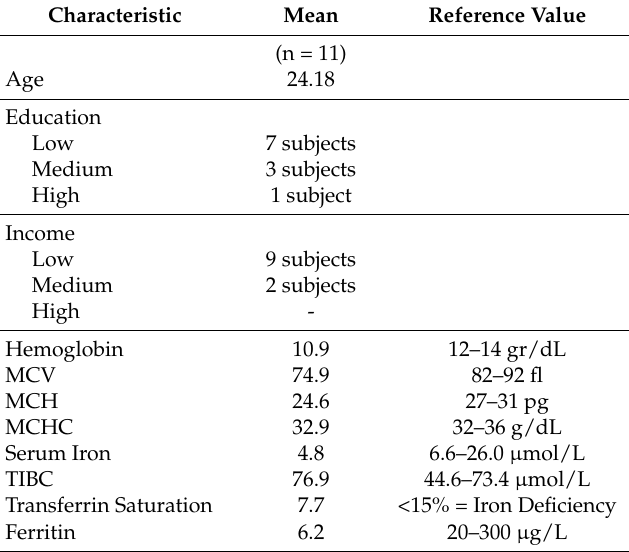
Table 3. Distribution characteristics of the selected